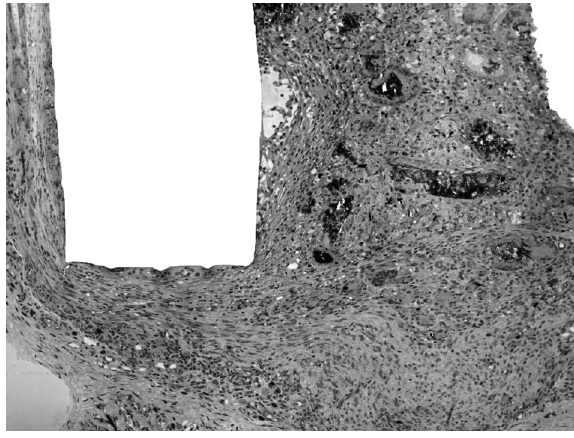
Figure 6. Inflammatory response in diabetic MTA Fillapex group at day 30: presence of a mild inflammatory cell infiltration consisting of macrophages and lymphocytes after 30 days (hematoxylin-eosin,